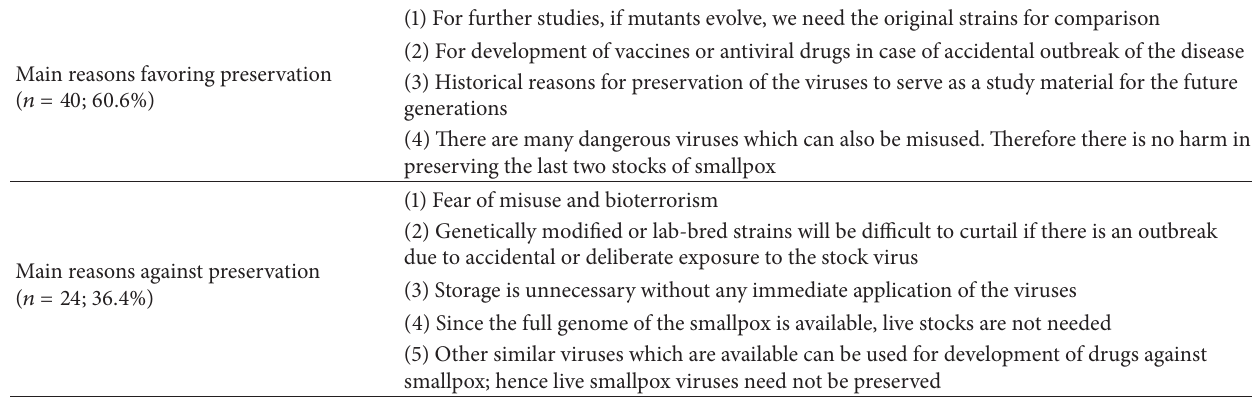
Table 2: Major reasons given by participants to preserve/not to preserve variola